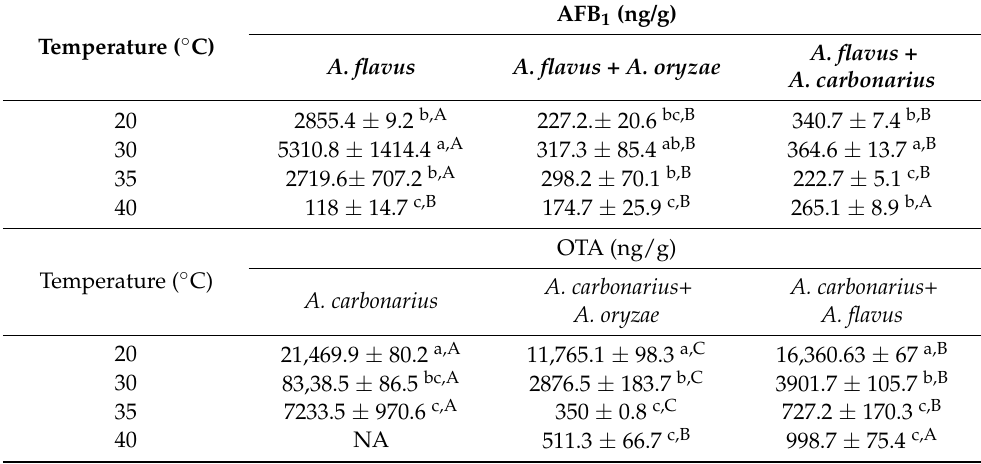
Table 1. AFB 1 and OTA production (ng/g) of A. flavus and A. carbonarius in single and mixed cultures at static temperatures on